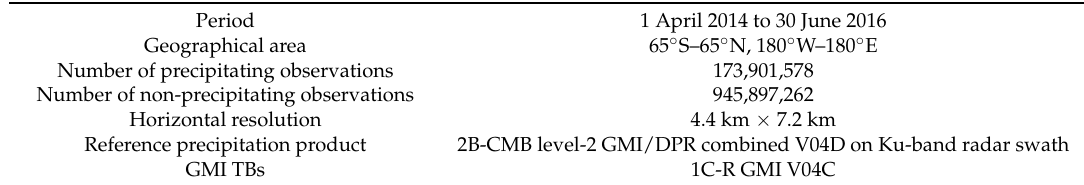
Table 1. Description of the observational database